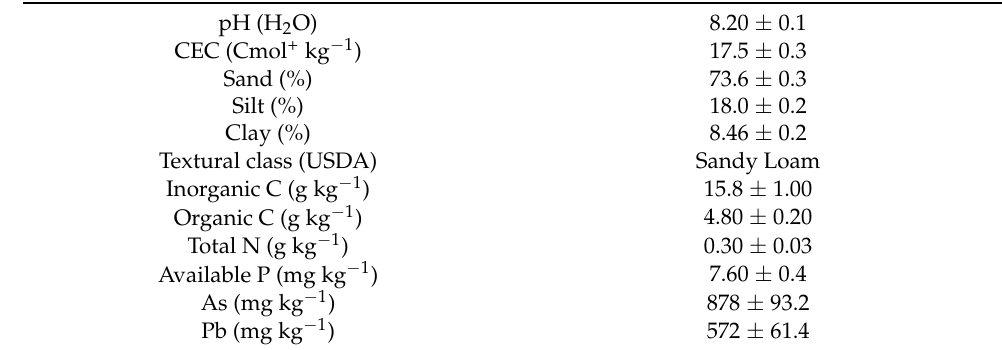
Table 1. Physical–chemical properties of As and Pb contaminated soil. Values represent the mean ( n = 3) ± standard